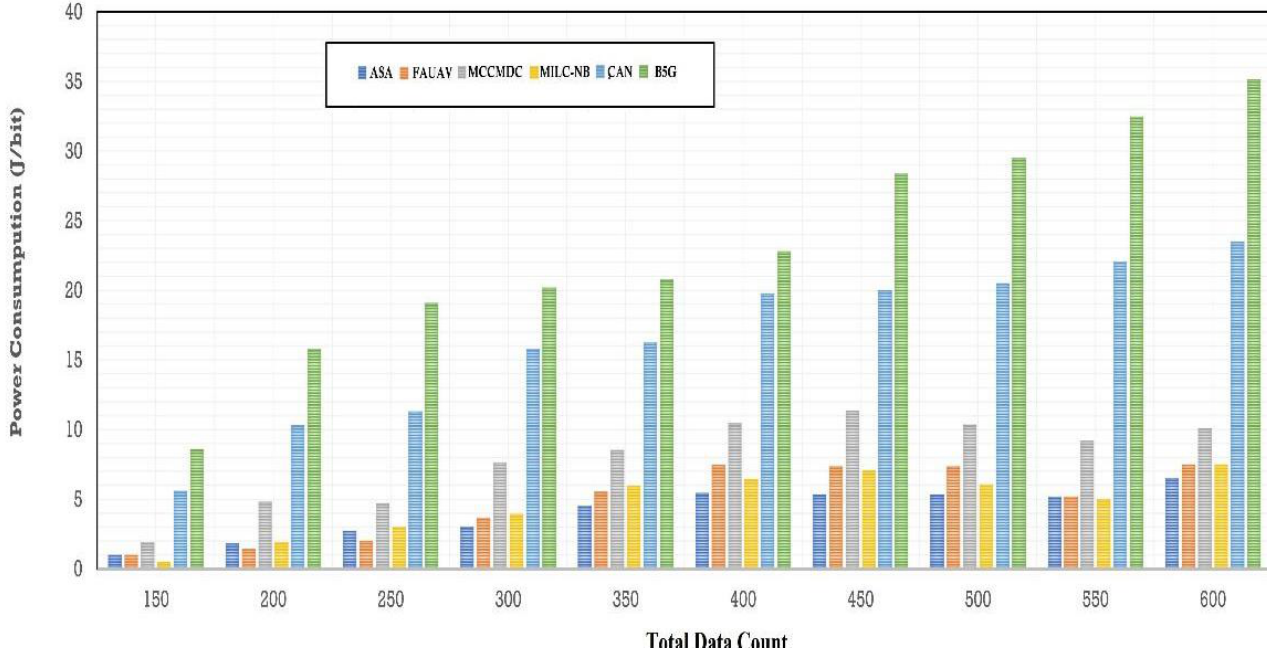
Figure 6. The average energy consumption before data obfuscation.